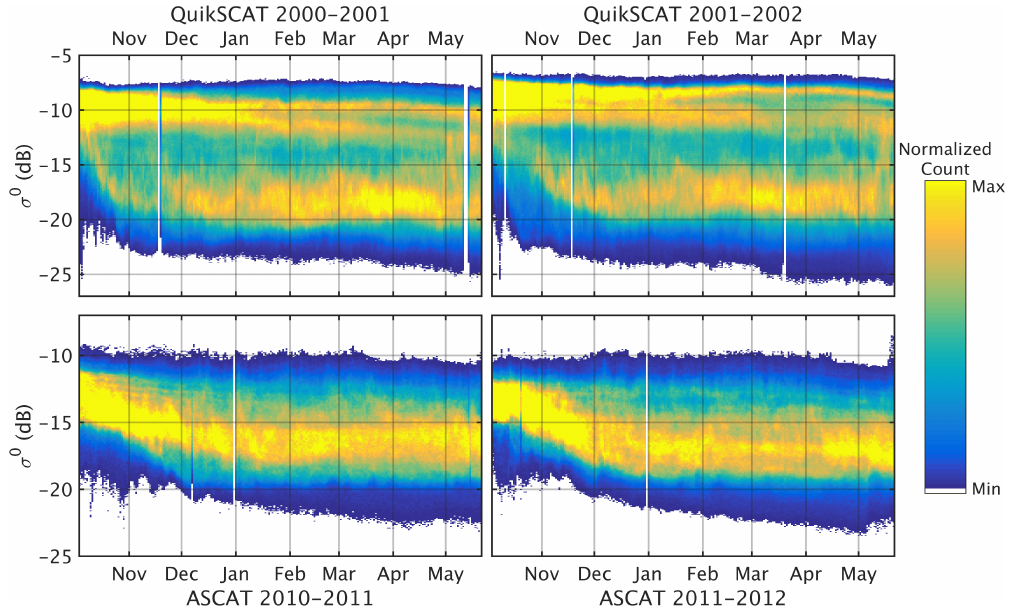
Figure 1. Time series of daily histograms for QuikSCAT ( top row ) for the winters of 2000/2001 and 2001/2002 and ASCAT ( bottom row ) for the winters of 2010/2011 and 2011/2012. The QuikSCAT distribution demonstrates a separation of modes corresponding to FY ice and MY ice, whereas the ASCAT distribution does not clearly demonstrate such separation. Each histogram in the time series is normalized by its maximum bin